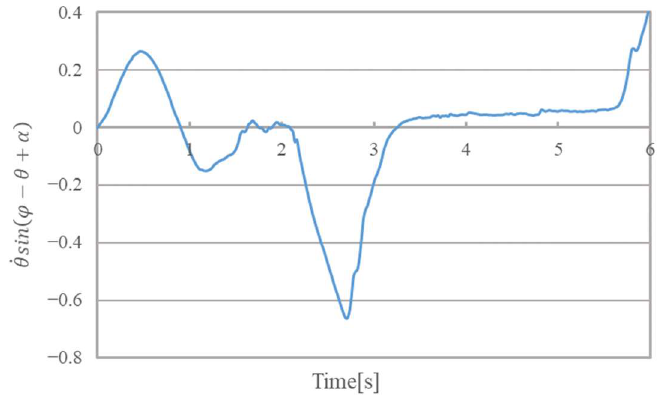
. θ sin ( ϕ − θ + α ) (experimental